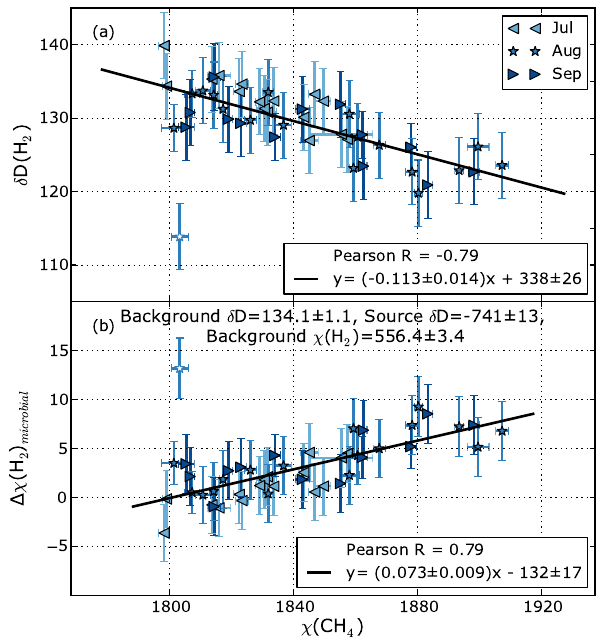
Fig. 8. (a) : δ D plotted against χ( CH 4 ) for the samples taken on flights to Chennai south of 40 ◦ N in the summer monsoon season. (b) : Estimated amount of H 2 (as a χ( H 2 ) increase) produced by monsoon-related microbial processes ( 1χ( H 2 ) microbial ) that would be required to explain the observed isotope depletions, plotted against χ( CH 4 ) . Calculations are done under the assumption that all D-depletion is caused by microbially produced H 2 with a source signature of δ D of ( − 741 ± 13)‰ (Walter et al., 2011). Solid lines indicate W-Y fits (Cantrell, 2008). The open symbol indicates a sample with a back trajectory originating outside of the monsoon system that was not taken into account in the